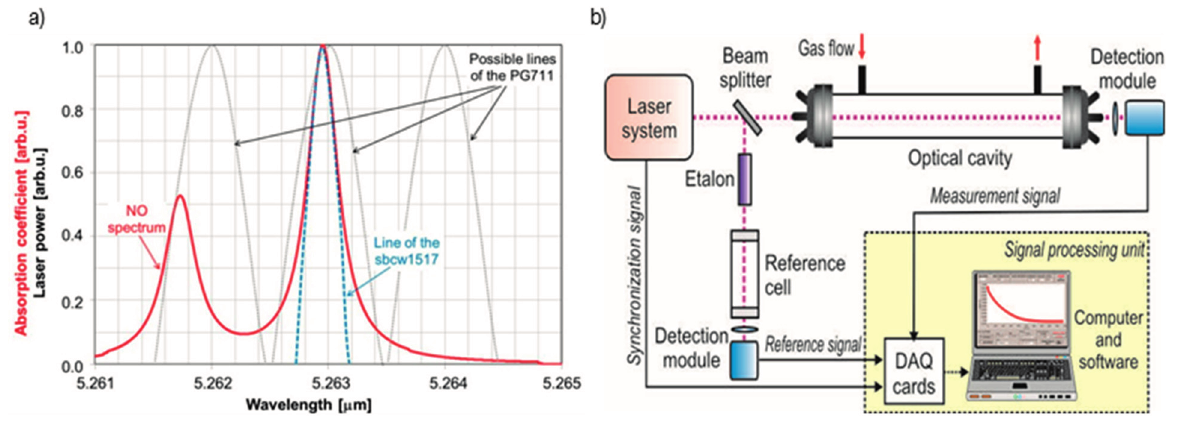
Figure 4. ( a ) Comparison of lasers linewidths and the nitric oxide absorption spectrum; ( b ) and block diagram of the experimental